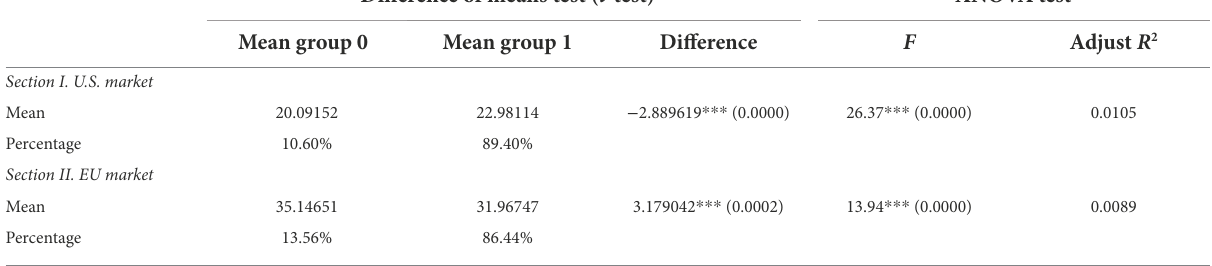
TABLE 7 Difference of means in the values of Board Gender Diversity and ANOVA test for the dummy variable of Policy Board Diversity. Difference of means test ( t -test) ANOVA